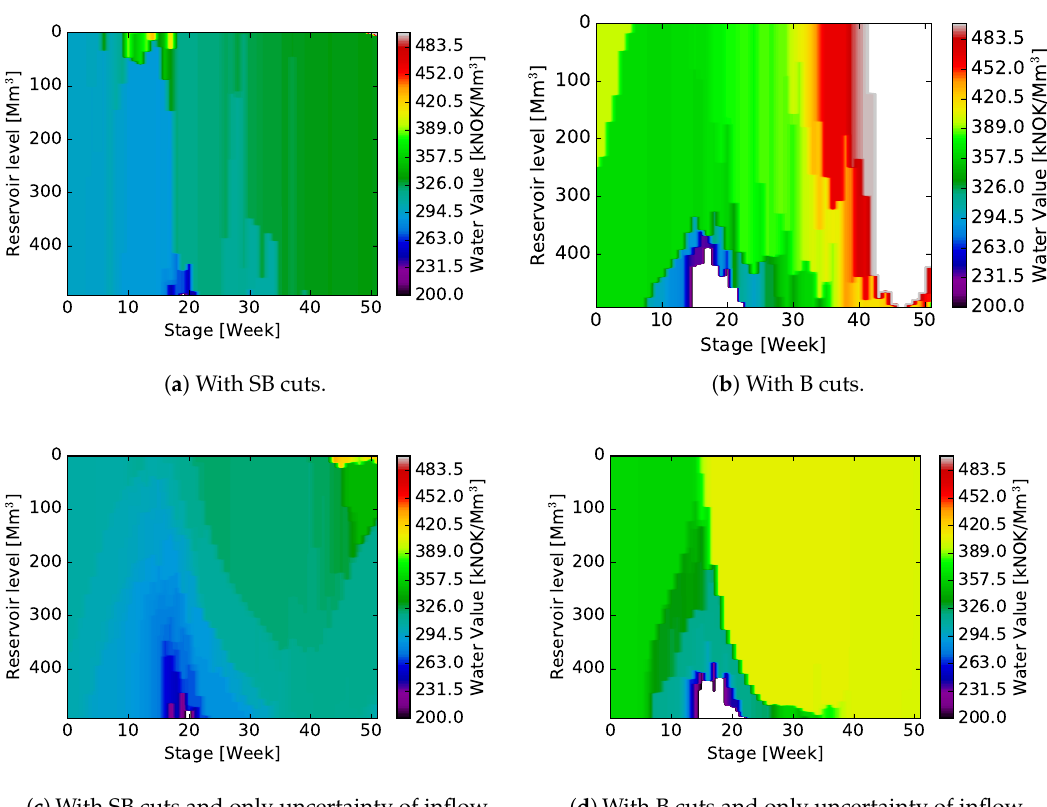
Figure 7. Water values for Reservoir 2 for the different case studies.